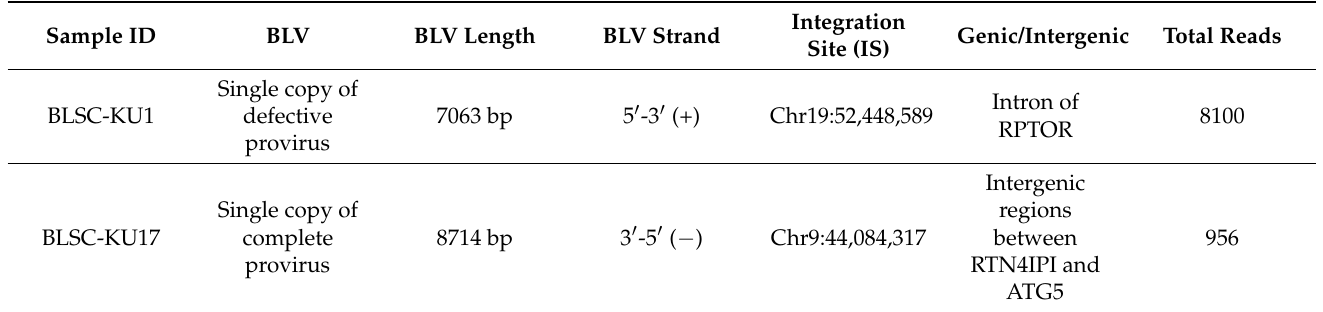
Table 2. Summary of the proviral structure of BLV and BLV integration sites in BLSC-KU1 and BLSC-KU17 cell